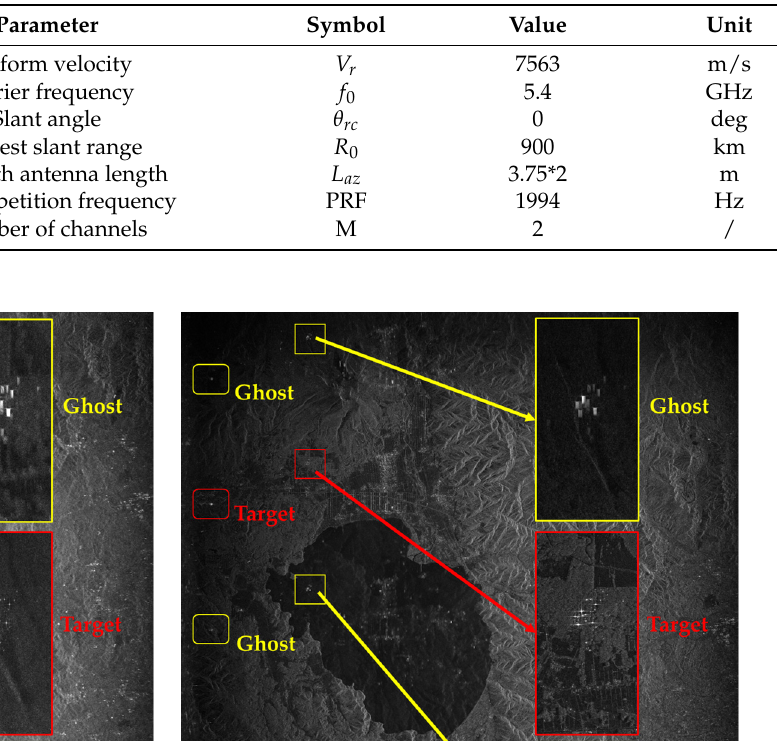
Table 7. GF-3 system parameters.